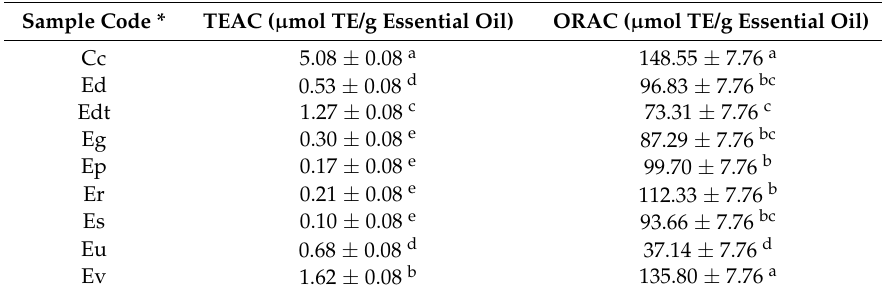
Table 2. The activity of essential oils of Corymbia citriodora and Eucalyptus spp. for scavenging ABTS+ and peroxyl